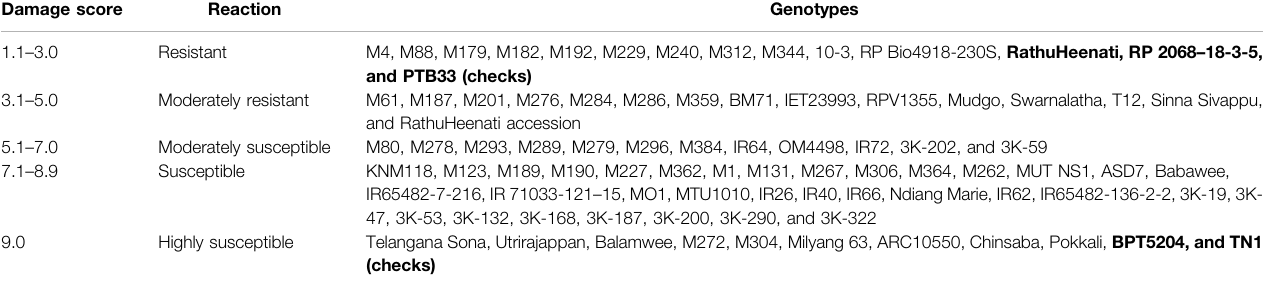
Bold genotypes are the checks used in the